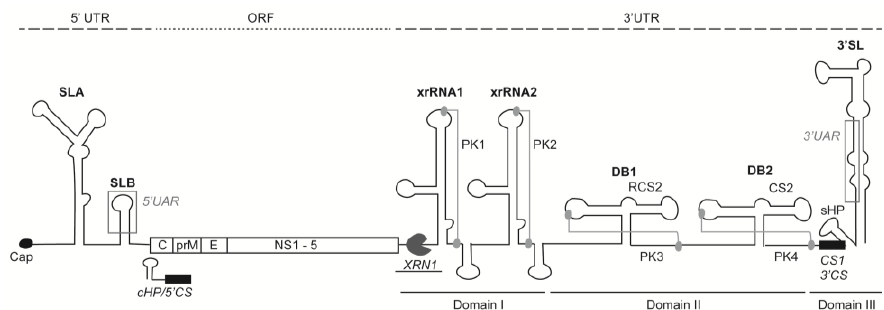
Figure 1. Schematic representation of dengue virus (DENV) genome. Location of the viral 5 ′ and 3 ′ untranslated region (UTR) and the open reading frame (ORF) indicating the structural (C-prM-E) and non-structural proteins (NS1-NS2A-NS2B-NS3-NS4A-NS4B-NS5). RNA structural elements located in the 5 (cid:48) end includes the exoribonuclease XRN1 resistant RNA (xrRNA), stem loop B (SLB), 5 (cid:48) UAR (upstream AUG region), capsid-coding region hairpin element (cHP) and 5 (cid:48) CS (conserved